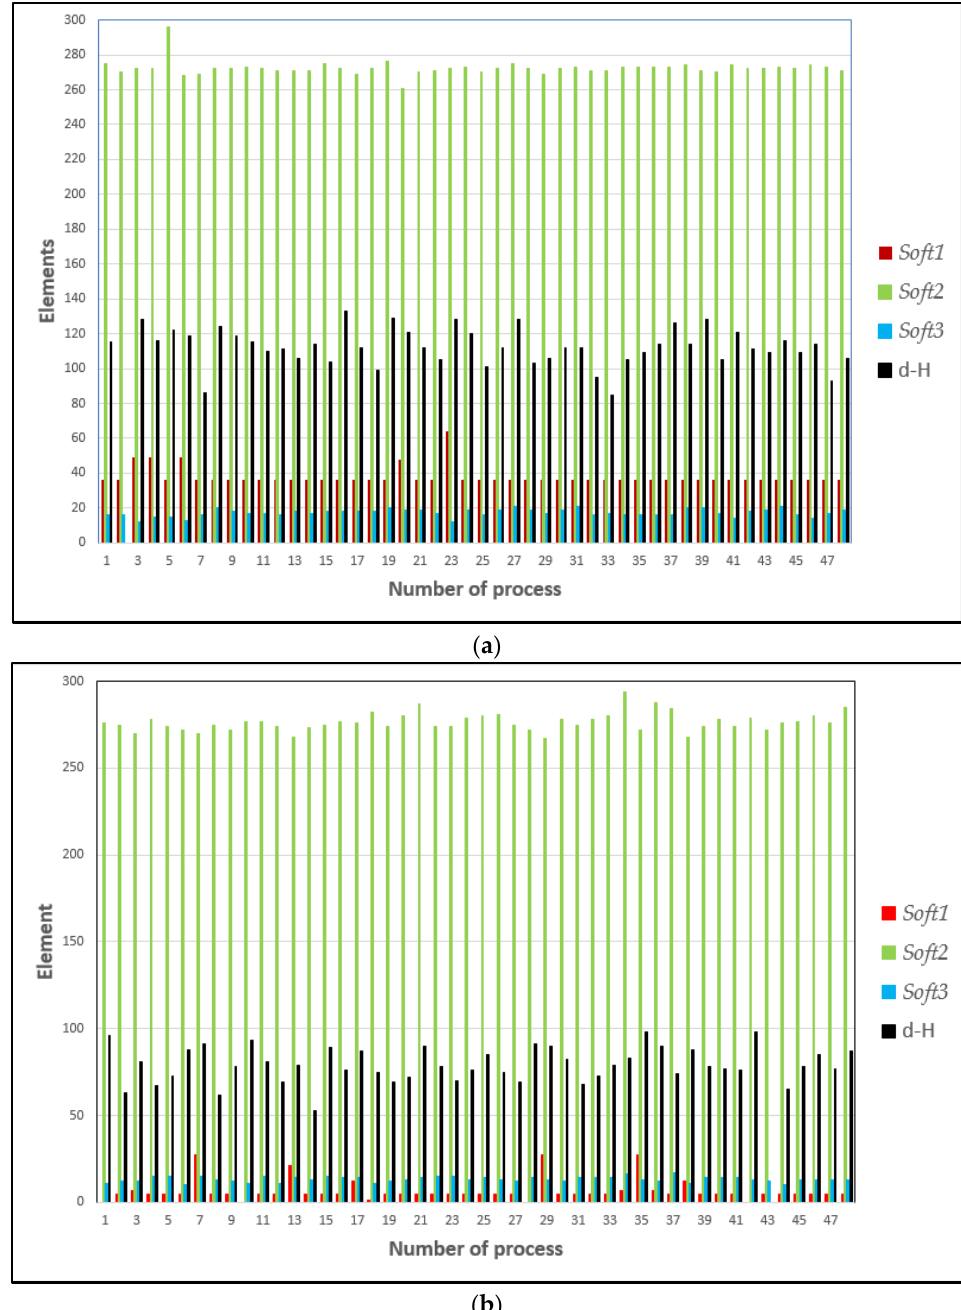
Figure 9. Best solution obtained by SACP with 48 processes with the soft constraints. ( a ) Instance large01. ( b ) Instance large02.